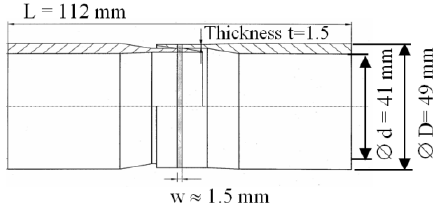
Figure 5: Specimen geometry.